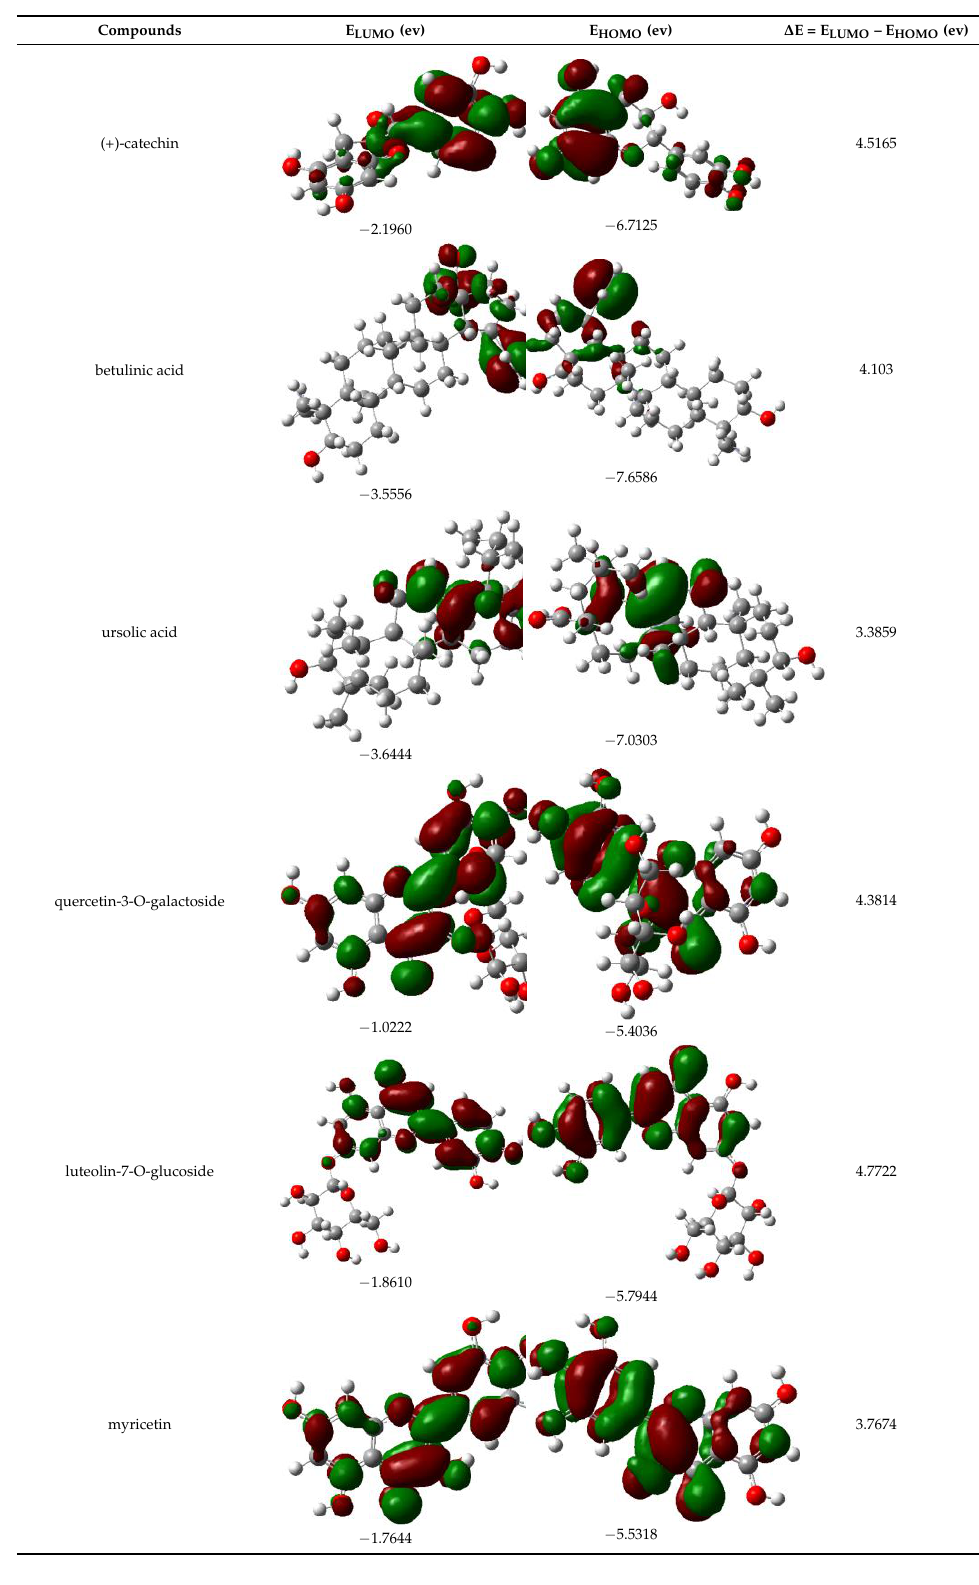
Table 3. The HOMO, LUMO and band energy gap (ev) for effective compounds of (+) - catechin, betulinic acid, ursolic acid, quercetin - 3 - O - galactoside, luteolin - 7 - O - glucoside, and myricetin in Sarracenia purpurea drug.